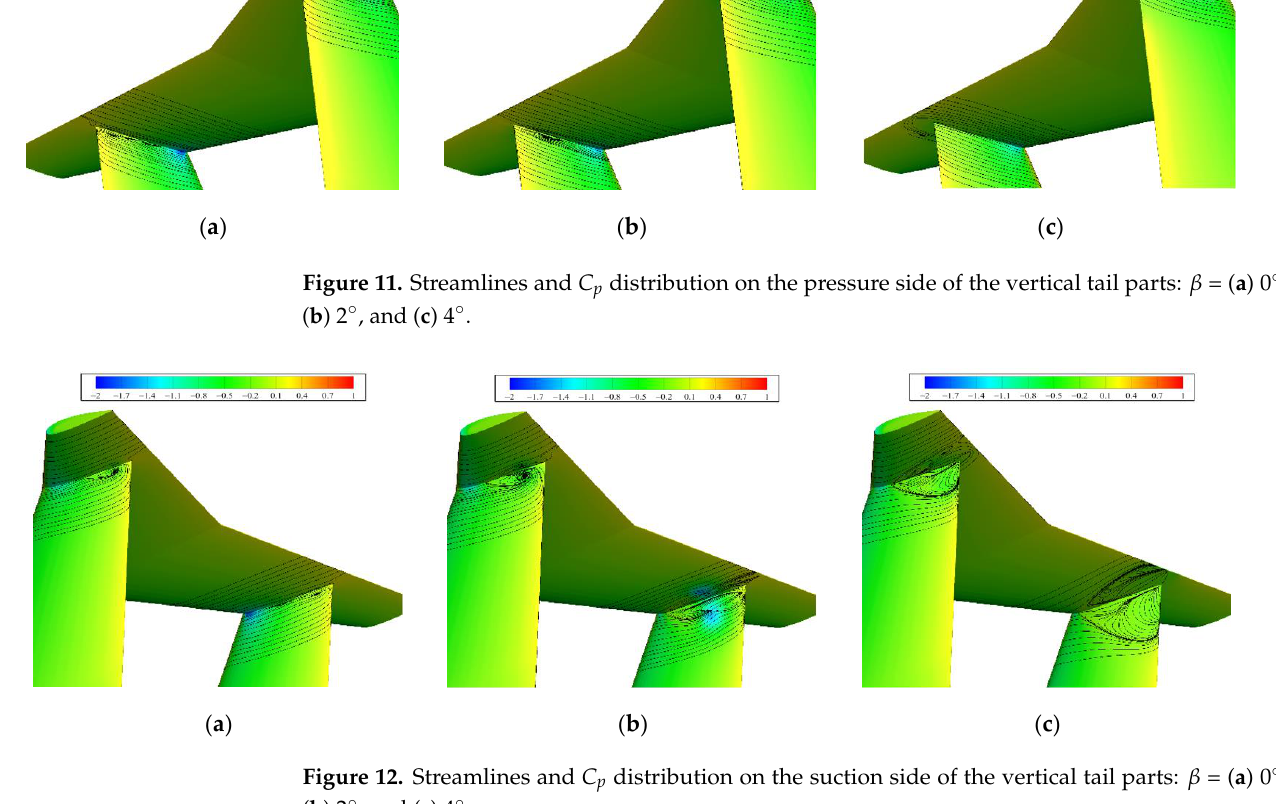
Figure 13. Ω = 0.52 isosurface , looking from the pressure side of vertical tail parts: β = ( a ) 0°, ( b ) 2°, and ( c ) 4°.